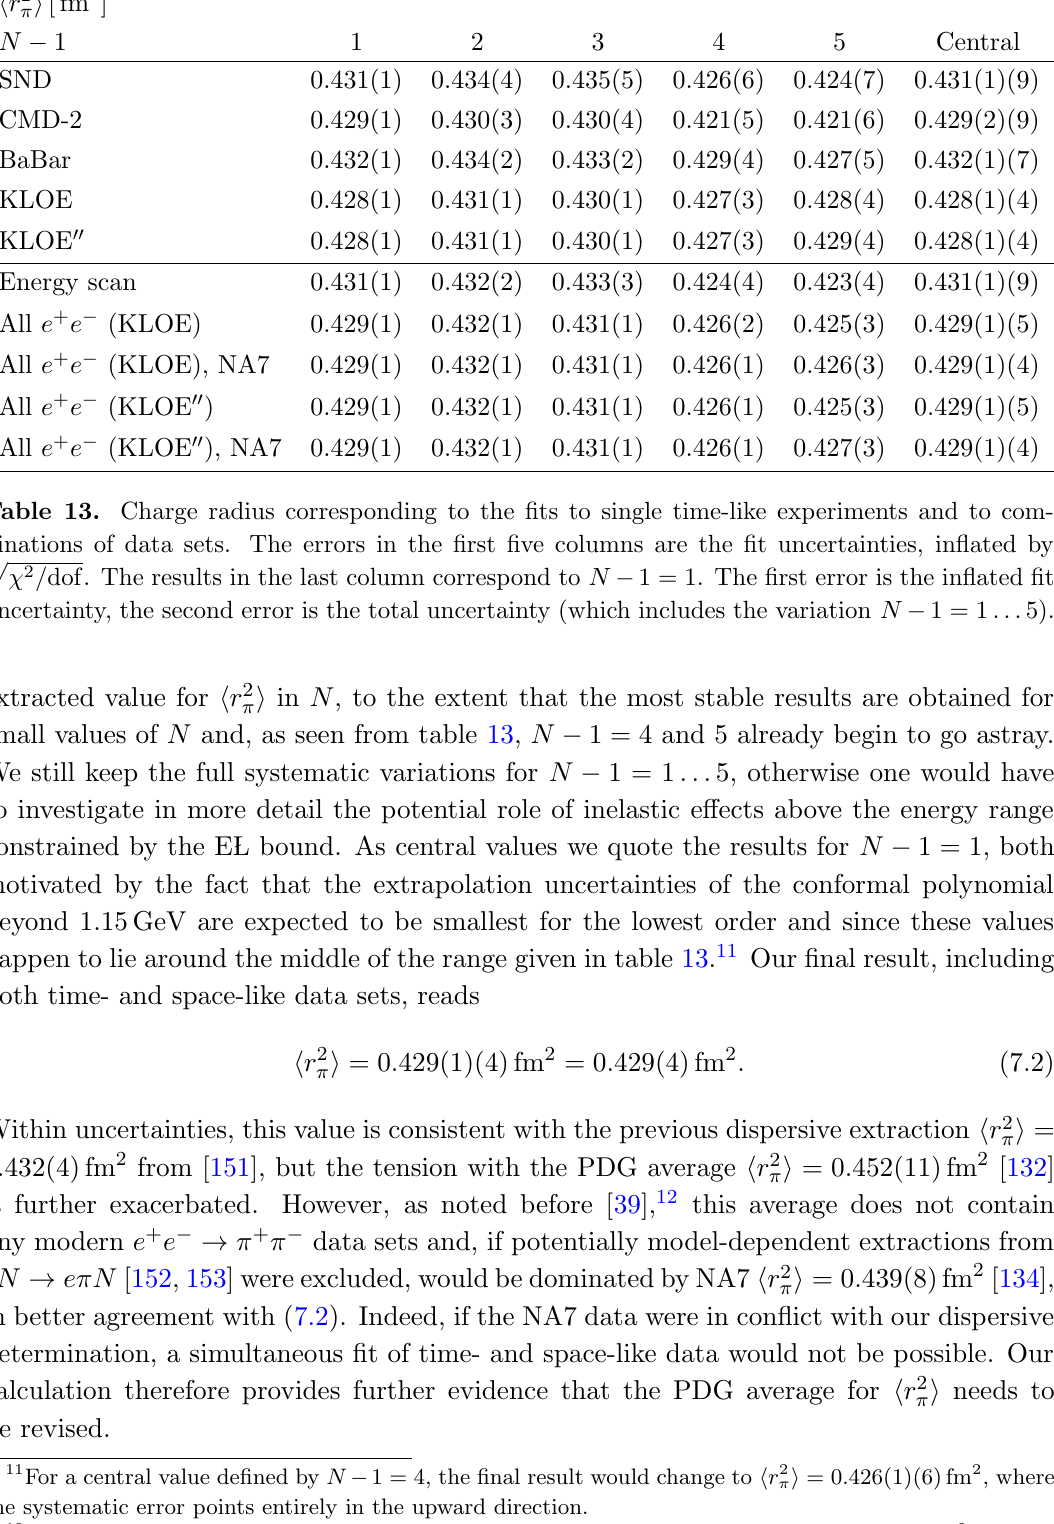
0 : 432(1) 0 : 431(1)